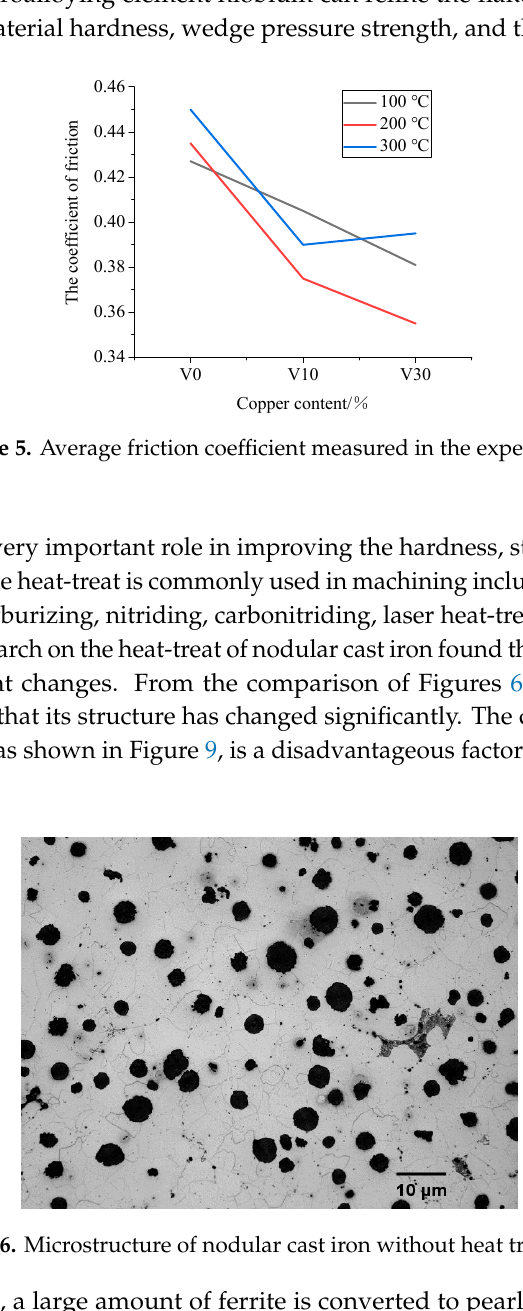
Figure 5. Average friction coefficient measured in the experiment.